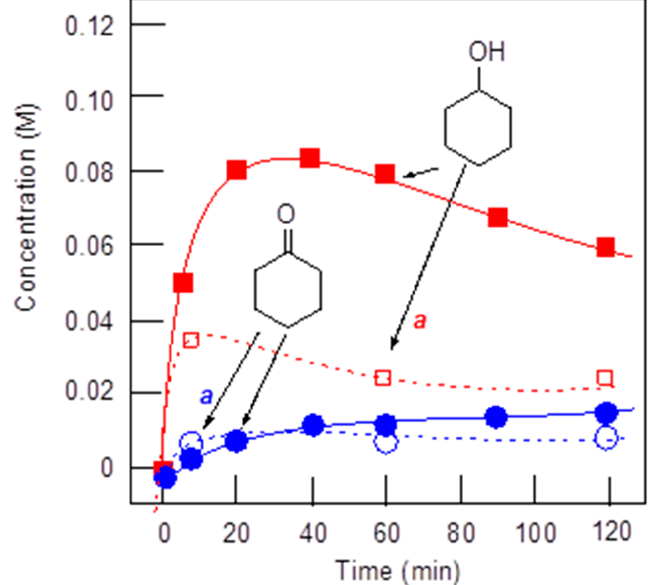
Figure 3. Accumulation of cyclohexanol and cyclohexanone in the oxidation of cyclohexane (0.46 M) with H 2 O 2 (0.5 M containing 0.94 M H 2 O) catalyzed by complex 1 (2.5 × 10 − 4 M) in the presence of HNO 3 (0.05 M) at 40 °C. Concentrations of products were measured by GC after the reduction of the reaction sample with solid PPh 3 . The yield of oxygenates after 60 min was 22% (TON 400). Curves a : the same in the absence of HNO 3 .